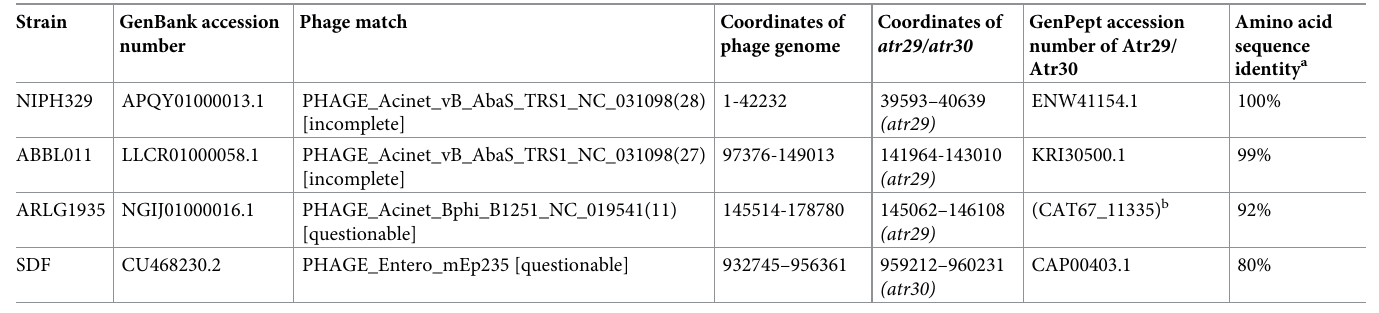
Table 3. A . baumannii genome sequences with phage genomes carrying an atr gene for 4-O-acetylation of the CPS. Strain GenBank accession